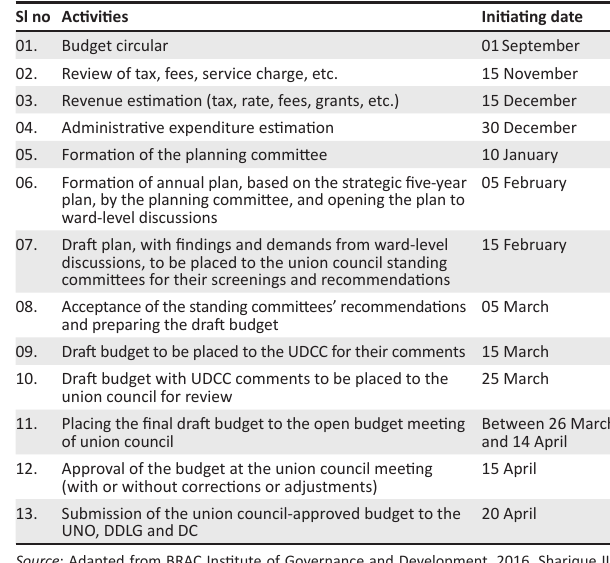
TABLE 1: Union council budget